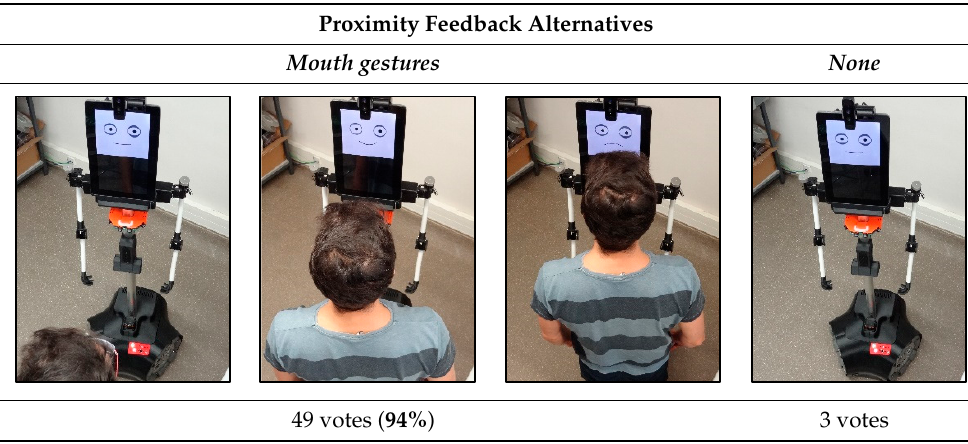
Table 8. Alternatives considered to implement the proximity feedback and votes received.